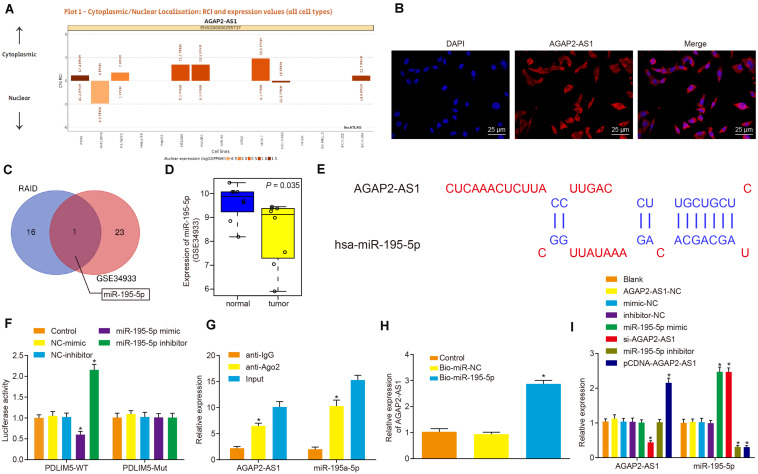
LncRNA AGAP2-AS1 binds to miR-195-5p and inhibits its expression in vitro. (A) Subcellular localization of lncRNA AGAP2-AS1 predicted by the lncATLAS website (http://lncatlas.crg.eu/). (B) Subcellular localization of AGAP2-AS1 in cells analyzed by FISH assay (×400). (C) Intersection of miRNAs possibly regulated by lncRNA AGAP2-AS1 predicted by the RAID database (http://www.rna-society.org/raid/search.html) and lowly-expressed miRNAs in prostate cancer in microarray data GSE3325. (D) miR-195-5p expression in prostate cancer in microarray data GSE3325. (E) The binding sites between AGAP2-AS1 and miR-195-5p predicted by the lncBase website. (F) LncRNA AGAP2-AS1 binding to miR-195-5p verified by dual-luciferase reporter assay in cells. The control group was used as a control (*p < 0.05 vs. the control group). (G) Binding of lncRNA AGAP2-AS1 to miR-195-5p analyzed by RIP assay in cells. The anti-IgG was used as a control (*p < 0.05 vs. anti-IgG). (H) Enrichment of lncRNA AGAP2-AS1 probed by miR-195-5p detected using RNA pull-down assay in cells. The control group was used as a control (*p < 0.05 vs. the control group). (I) miR-195-5p and lncRNA AGAP2-AS1 expression determined using RT-qPCR in VCaP cells after transfection with miR-195-5p mimic or inhibitor, pCDNA-AGAP2-AS1 or si-AGAP2-AS1. The blank group was used as a control. *p < 0.05 vs. VCaP cells without transfection. The above results were all measurement data expressed as mean ± standard deviation. One-way ANOVA was used for comparisons among multiple groups. The experiment was repeated 3 times.